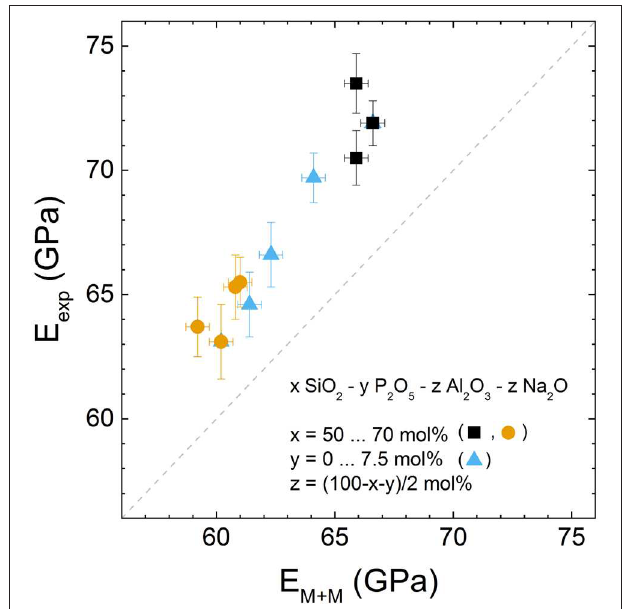
FIGURE 8 | Comparison of Young’s moduli determined by ultrasonic echometry (E exp ) and by the Makishima-Mackenzie model (E M line marks the ideal case of complete agreement. The Makishima-Mackenzie model slightly underestimates the measured values.